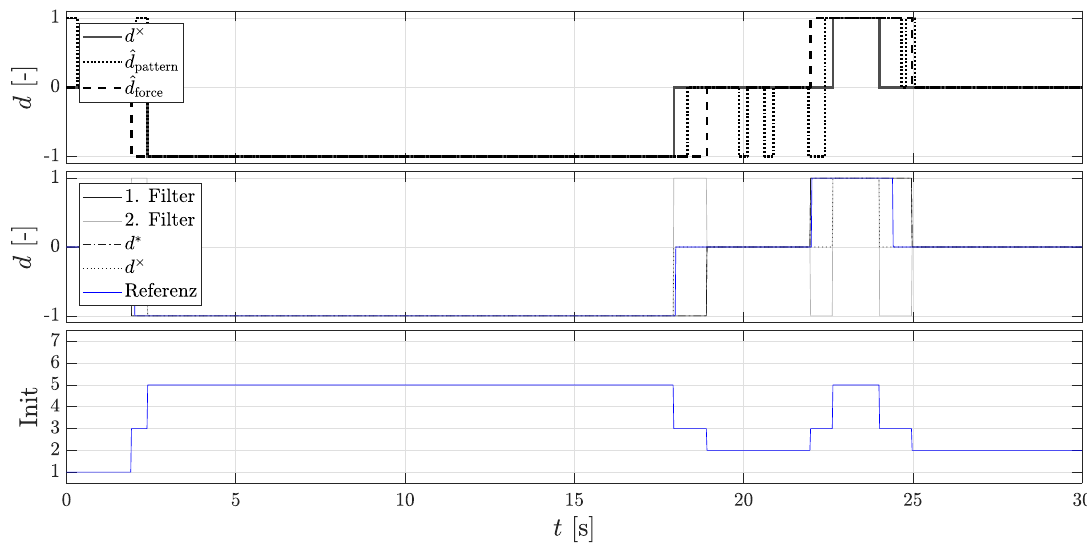
Figure 6. Procedure of the Dual-Localization filter for a complete parking process. ( Top ): The rolling directions of the DWPC signal d × , the pattern recognition method ˆ d pattern , and the force equilibrium method ˆ d force ; ( Middle ): rolling directions of the 1st and the 2nd localization filter, the fused estimated rolling direction of the new methods d ∗ , the rolling direction of the DWPC signal and the reference direction; ( Bottom ): Initialization states.